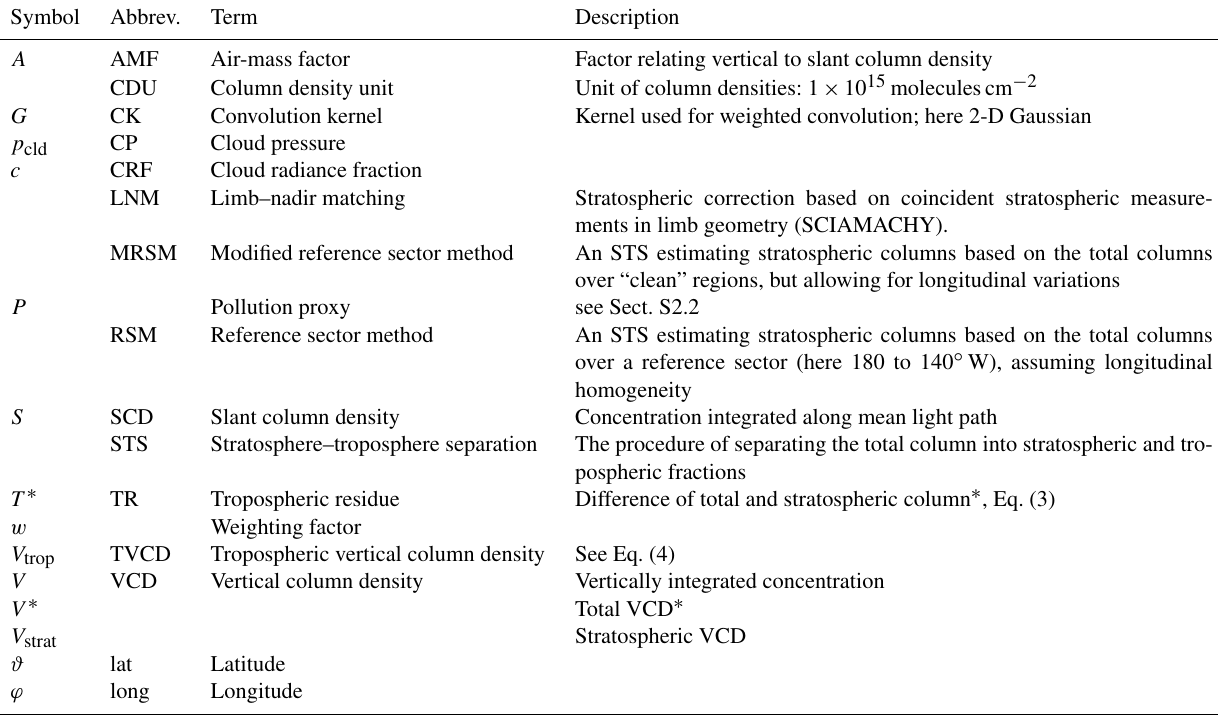
Table 2. Terms and abbreviations related to STREAM used in this study. Symbol Abbrev. Term Description A AMF Air-mass factor Factor relating vertical to slant column density CDU Column density unit Unit of column densities: 1 × 10 15 moleculescm − 2 Convolution kernel Kernel used for weighted convolution; here 2-D Gaussian Cloud pressure Cloud radiance fraction Limb–nadir matching Stratospheric correction based on coincident stratospheric measure- ments in limb geometry (SCIAMACHY). Modified reference sector method An STS estimating stratospheric columns based on the total columns over “clean” regions, but allowing for longitudinal variations Pollution proxy see Sect. S2.2 Reference sector method An STS estimating stratospheric columns based on the total columns over a reference sector (here 180 to 140 ◦ W), assuming longitudinal homogeneity Slant column density Concentration integrated along mean light path Stratosphere–troposphere separation The procedure of separating the total column into stratospheric and tro- pospheric fractions Tropospheric residue Difference of total and stratospheric column ∗ , Eq.